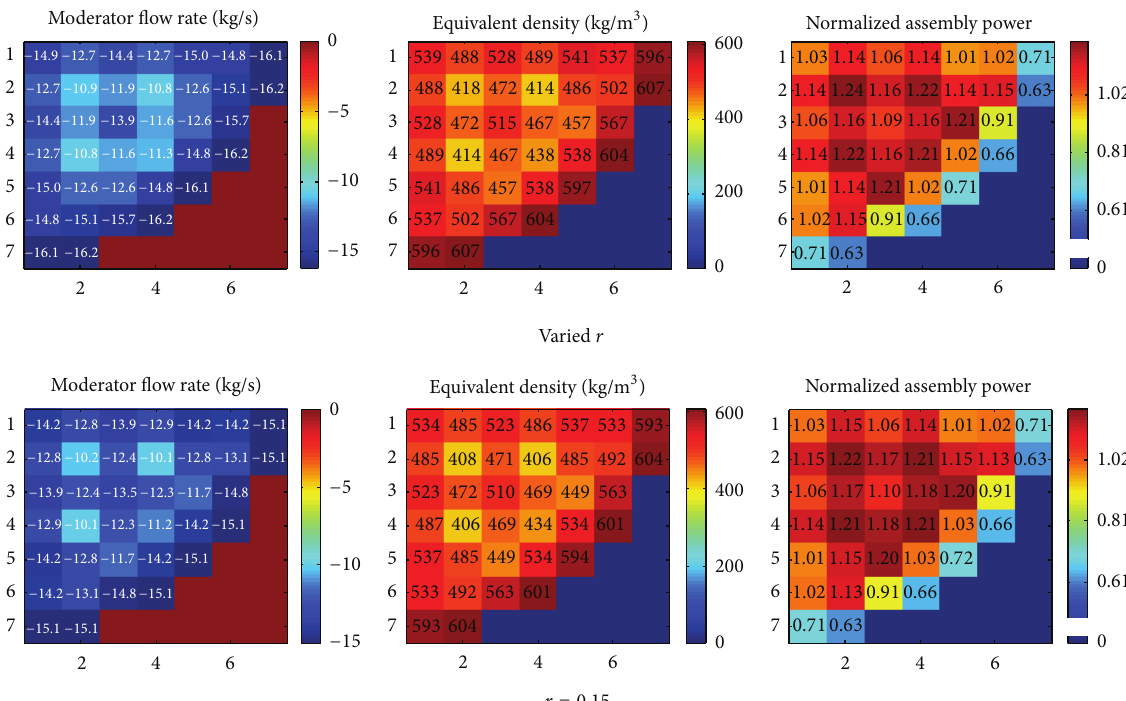
Figure 5: Moderator flow rate, equivalent density, and normalized assembly power (reference value 24.59 MW) in varied 𝑟 case and 𝑟 = 0.15 case.